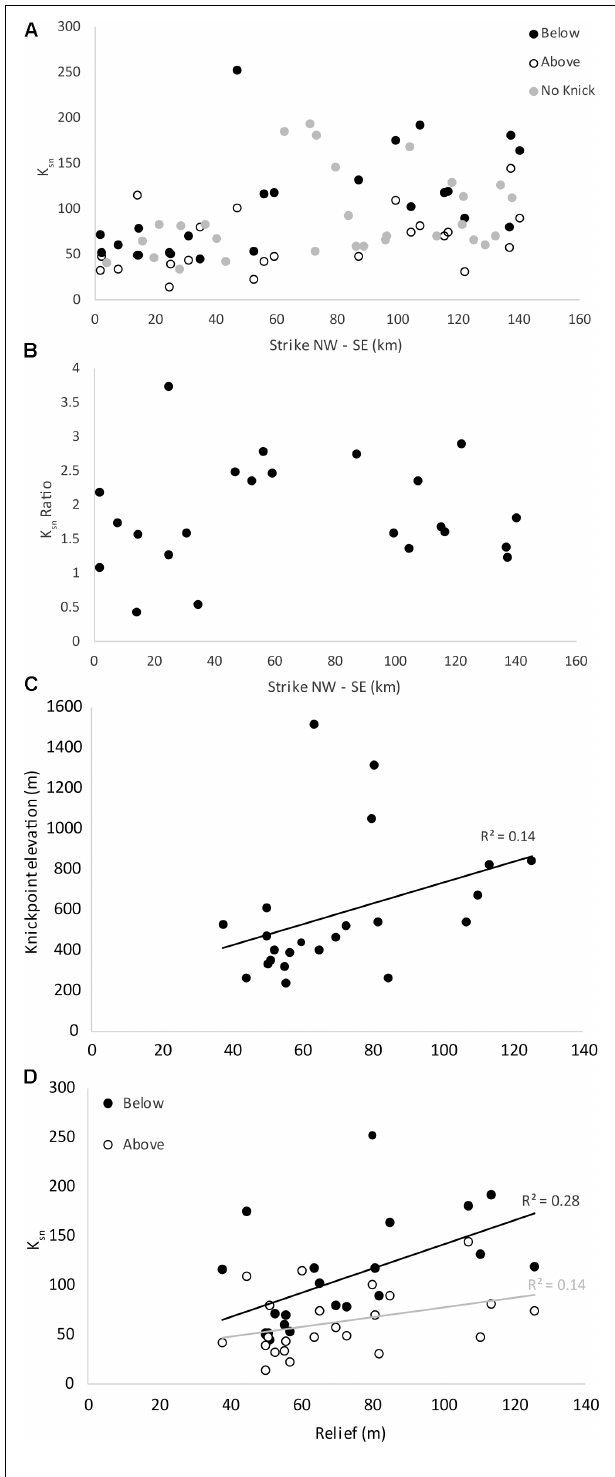
FIGURE 8 | (A) K sn against distance along strike of Guadalcanal showing the difference in value for the river above and below the knickpoints (where present) and k sn for the whole river (where knickpoints are absent). (B) K sn ratio (below knickpoint/above knickpoint) of rivers with knickpoints along the island of Guadalcanal. (C) Knickpoint elevation and (D) K sn against topographic relief for